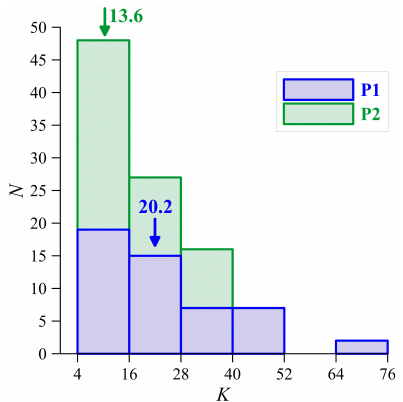
Figure 4. Distribution of the K -parameter values in the equatorial projection of the proton isotropy boundaries in the P1 (blue) and P2 (green) channels. The arrows show the median K values in both channels as well as the K = 8 critical threshold previously defined for the current sheet scattering